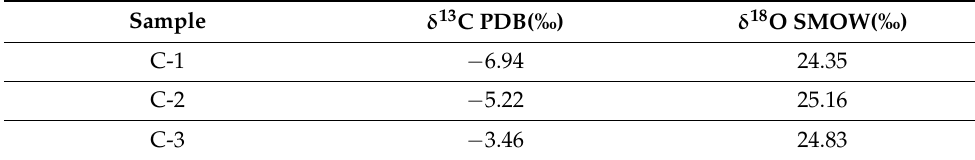
Table 2. Carbon and oxygen isotope composition of calcite samples from Salmi